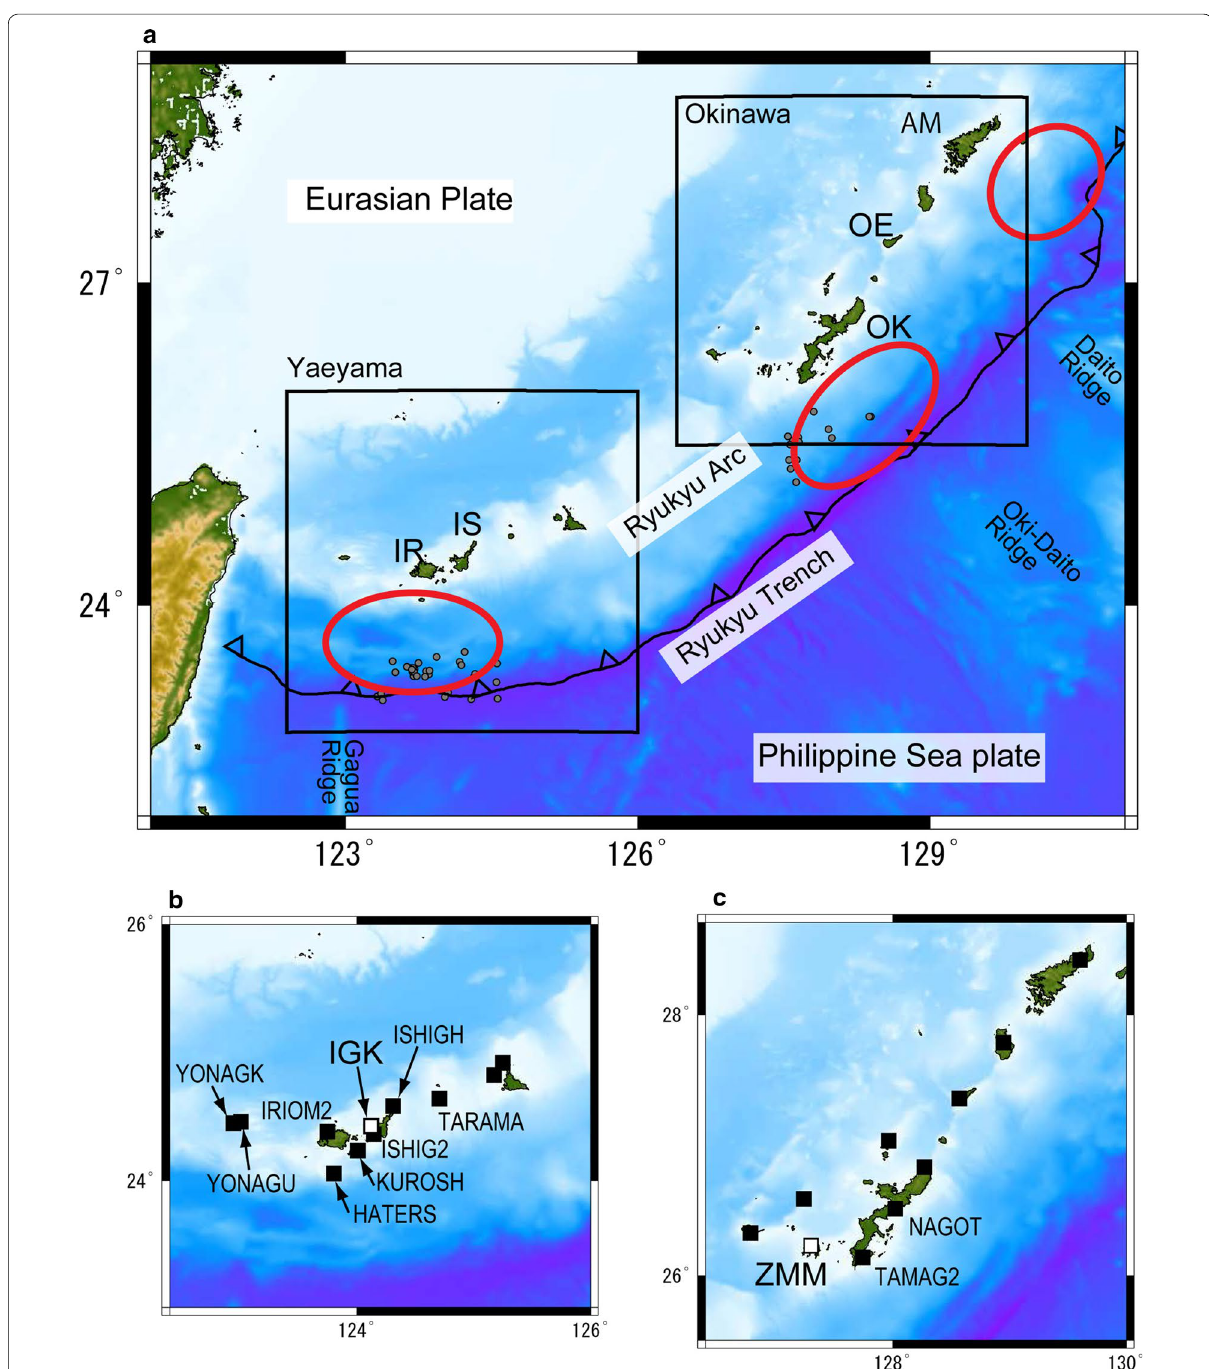
Fig. 1 Distributions of very low frequency earthquakes (VLFEs) and observation stations within the study area. a IR Iriomote Island, OE Okinoerabu Island, OK Okinawa Island, AM Amami Island. Red ovals show the major clusters of VLFEs (Nakamura and Sunagawa 2015). Small gray circles show the hypocenters of the ordinary earthquakes whose amplitudes were compared with those of the LFEs in Fig. 11. b Enlarged area for the Yaeyama region. Open squares show the F-net stations; solid squares show the JMA stations. c Same as b but for the Okinawa